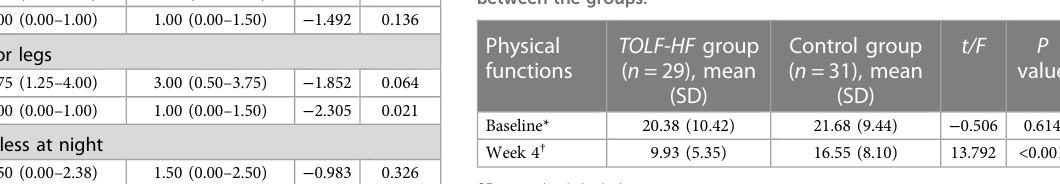
TABLE 5 Comparison of physical functions at baseline and week 4 between the